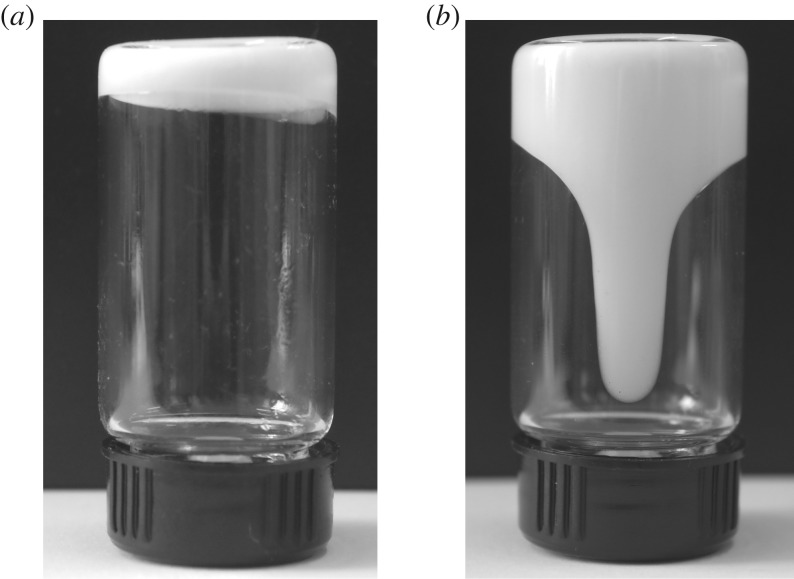
Digital images of a bottom-up bottle CaCO3-based NIMs when holding (a) at 0°C for 5 min and (b) at 23°C for 10 s.